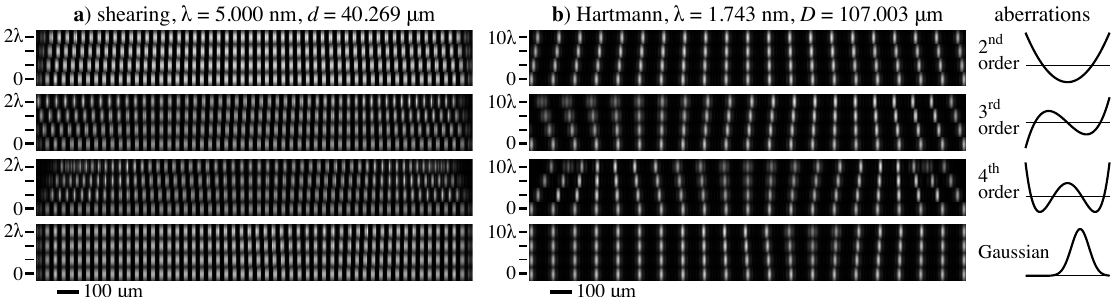
Figure 10. ( a ) Shearing and ( b ) Hartmann aberration modeling showing four different aberration types and varying amplitudes. Each row is a detail extracted from an intensity calculation performed for a single grating or grid on a 2mm wide domain. The scale bars on the left show the uniformly-weighted aberration rms amplitudes for the polynomials and the peak height for the Gaussian